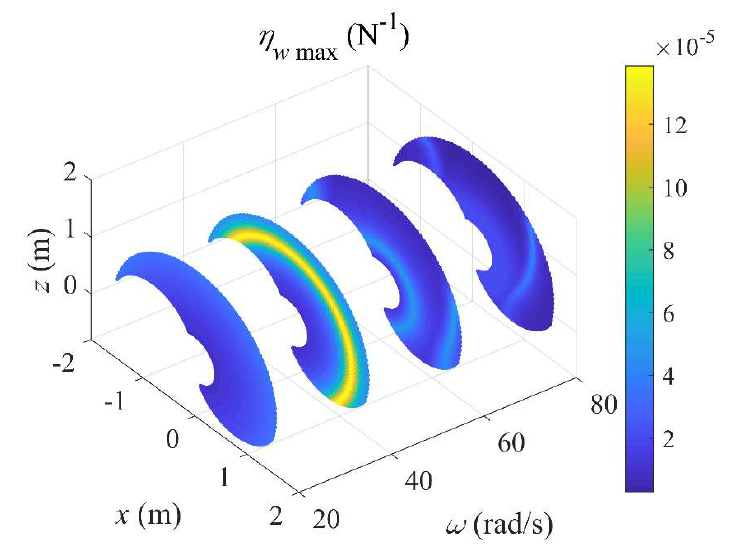
Figure 7. Distribution of η wmax over robot workspace. Table 3. Mean and maximum values of both indices over workspace with different excitation frequencies.